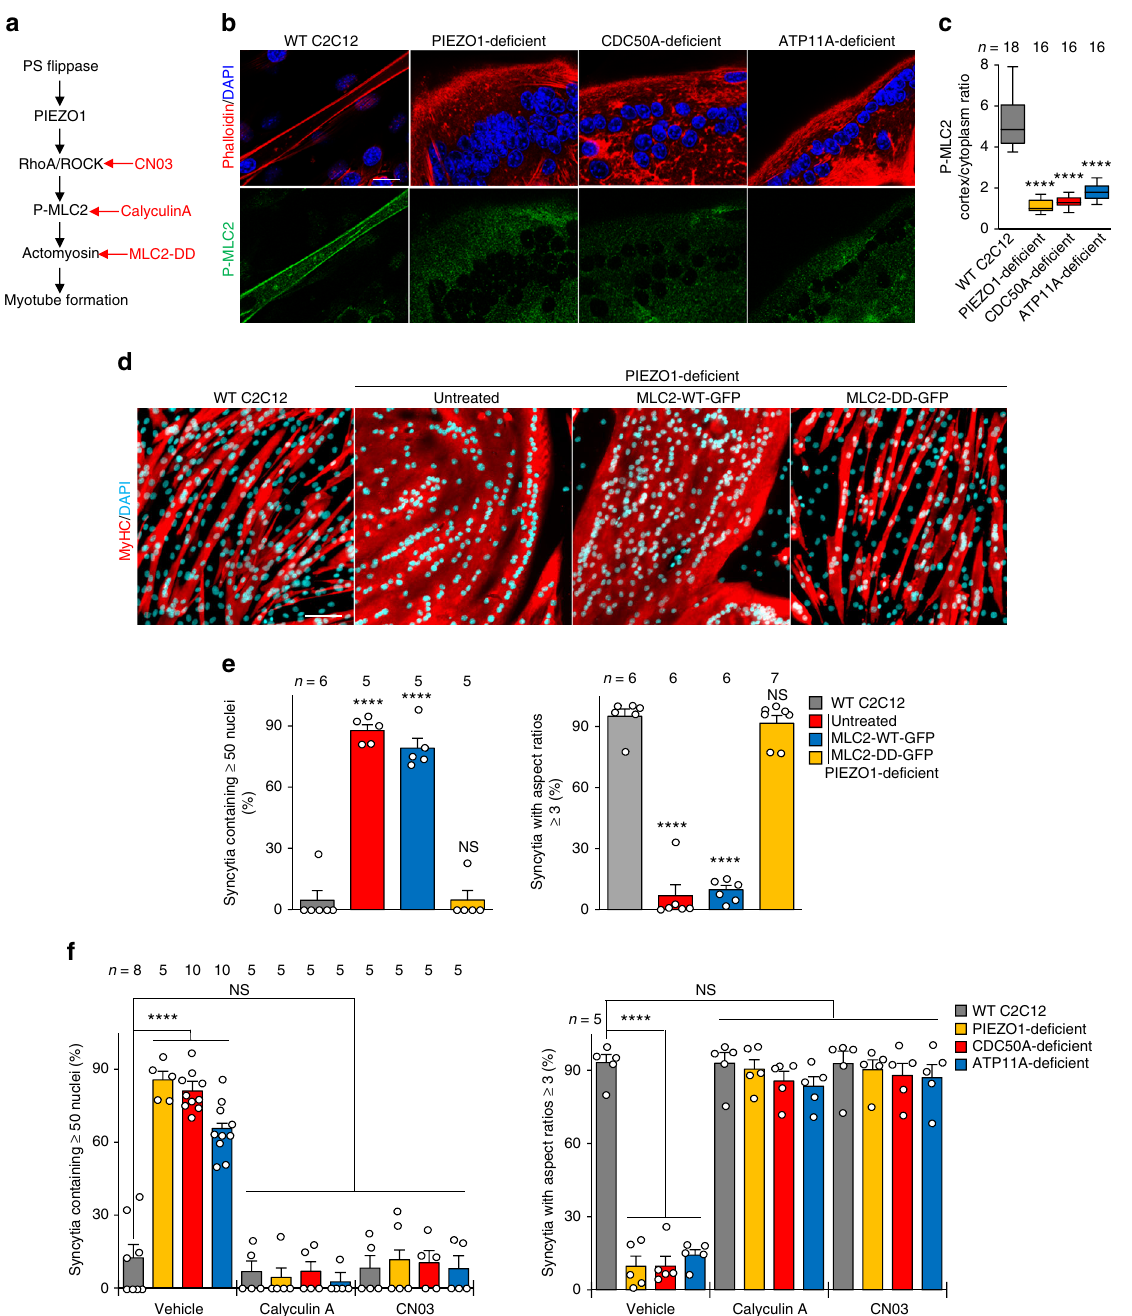
Fig. 7 RhoA/ROCK-mediated actomyosin formation via the PS fl ippase/PIEZO1 pathway required for myotube morphology. a Schematic diagram of the PS fl ippase/PIEZO1 axis (black) and activators for the RhoA/ROCK/actomyosin pathway (red). b , c Suppressed cortical accumulation of phosphorylated MLC2 (P-MLC2) in PS fl ippase-de fi cient and PIEZO1-de fi cient myotubes. b Localization of P-MLC2 (anti-P-MLC2 antibody, green), F-actin (phalloidin, red), and nuclei (DAPI, cyan) in WT, PIEZO1-de fi cient, CDC50A-de fi cient, and ATP11A-de fi cient C2C12 syncytia. Intense co-localization of P-MLC2 and F- actin was observed on the cell periphery of WT myotubes. c Cortex vs. cytoplasm ratio of P-MLC2 signals in b . d , e Rescue of myotube formation by stable expression of a phospho-mimetic form of MLC2 in PIEZO1-de fi cient C2C12 syncytia. d Syncytia formed by WT and PIEZO1-de fi cient C2C12 myoblasts stably expressing WT MLC2 (MLC2-WT-GFP) or phospho-mimetic MLC2 (MLC2-DD-GFP) were visualized by immuno fl uorescent staining with anti- MyHC antibody (differentiated cells, red) and DAPI (nuclei, cyan). e Left: cell fusion evaluated as percentages of syncytia containing ≥ 50 nuclei in d . Right: polarized elongation evaluated as percentages of syncytia with aspect ratios ≥ 3 in d . f Rescue of myotube formation by activation of the RhoA/ROCK/ actomyosin pathway in PS fl ippase- or PIEZO1-de fi cient C2C12 syncytia. Syncytia formed by WT, PIEZO1-de fi cient, CDC50A-de fi cient, and ATP11A- de fi cient C2C12 syncytia after treatment with calyculin A (a myosin II activator) or CN03 (a selective RhoA activator) were visualized by immuno fl uorescent staining with anti-MyHC antibody and DAPI. Morphologies of the syncytia are shown in Supplementary Figure 6c. Left: cell fusion evaluated as percentages of syncytia containing ≥ 50 nuclei. Right: polarized elongation evaluated as percentages of syncytia with aspect ratios ≥ 3. **** P < 0.0001 (Student ’ s t -test). NS not signi fi cant, n sample number. Bar graphs represent mean ± S.E.M. Box and whiskers graph-line: median, box: upper and lower quartiles, whiskers: maxima and minima. Scale bars: 20 μ m ( b ), 100 μ m ( d